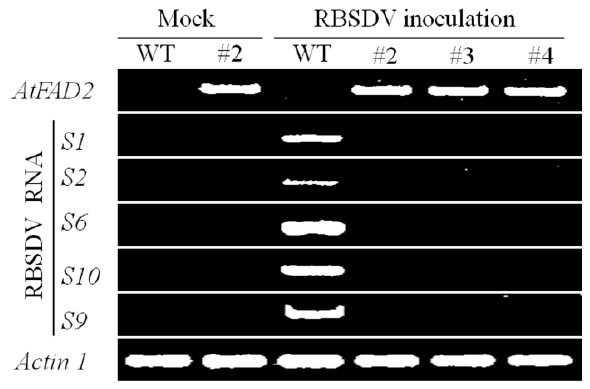
Figure 2. Expression analysis of the hpRNA construct and RBSDV target genes in transgenic rice plants. WT, wild-type Kitaake; #2, #3 and #4, three independent transgenic rice lines; Actin 1 , internal reference gene; mock, mock inoculation (negative control).